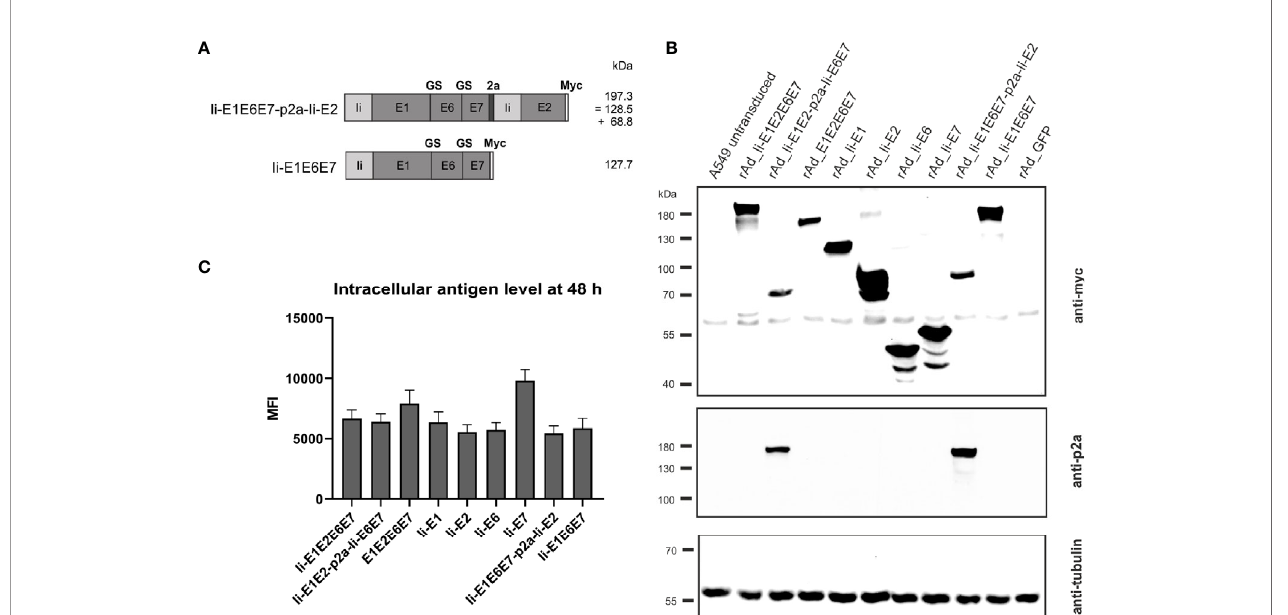
FIGURE 4 | Expression analysis of rAd-shuttled MfPV3 antigen constructs. (A) Schematic representation of the MfPV3 antigen variants Ii-E1E6E7-p2a-Ii-E2 and Ii- E1E6E7. Expected molecular weights (kDa) of the resulting polypeptides are shown. (B) Western blot analysis of A549 cell lysates 48 h following transduction with rAds encoding the indicated polypeptides at an MOI of 30. Antigens were detected with anti-myc (upper panel) and anti-p2a-peptide (middle panel) antibodies. As loading control, tubulin levels were monitored using an anti-tubulin antibody (lower panel). (C) Flow cytometry analysis of A549 cells 48 hours following transduction with rAds expressing the various MfPV3 antigens, at an MOI of 30. Intracellular staining was performed with anti-myc antibody. Depicted is the mean fl uorescence intensity (MFI) of the average of 3 independent experiments. Error bars indicate standard error of the